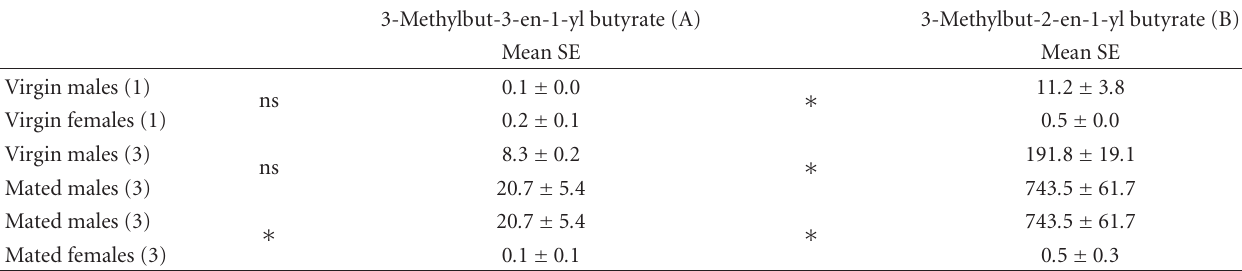
Table 2: Quantification ( µ g) of esters identified in whole body extracts of Thaumastocoris peregrinus (Heteroptera: Thaumastocoridae) virgin and mated males and females of di ff erent ages; 3–9 days (1) and 22–33 days (3). For each ester identified, ns: not statistically di ff erent, and ∗ : statistically di ff erent; SE: standard error. Statistical comparisons: GLM (generalized linear model) with Gaussian distribution ( P > 0 . 05). 3-Methylbut-3-en-1-yl butyrate